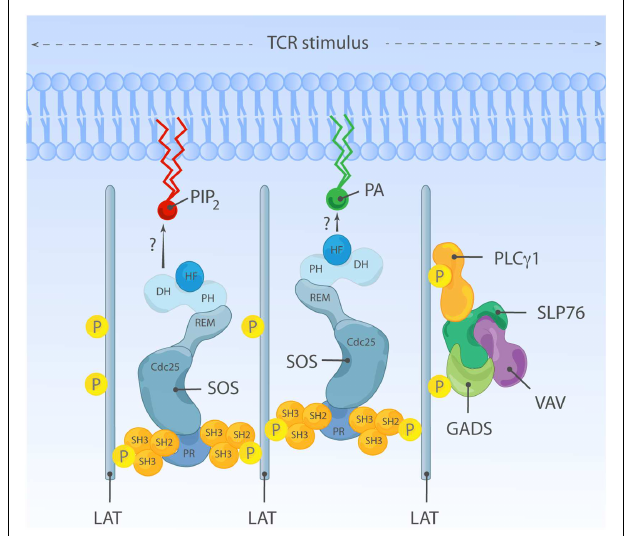
FIGURE 7 |An adapter function for SOS in oligomeric LAT clusters? Grb2-SOS complexes can serve as a cytosolic linkers and aggregate multiple LAT molecules and LAT signalosome-constituent proteins together. This SOS-containing complex may facilitate activation of other, non-canonical Ras-ERK signal transduction pathways such as activation of the MAPK p38, perhaps through aVav-Rac · GTP connection.We found that regulation of p38 is independent of any enzymatic function of SOS, further strengthening the notion that SOS can signal as an adapter to non-canonical pathways in